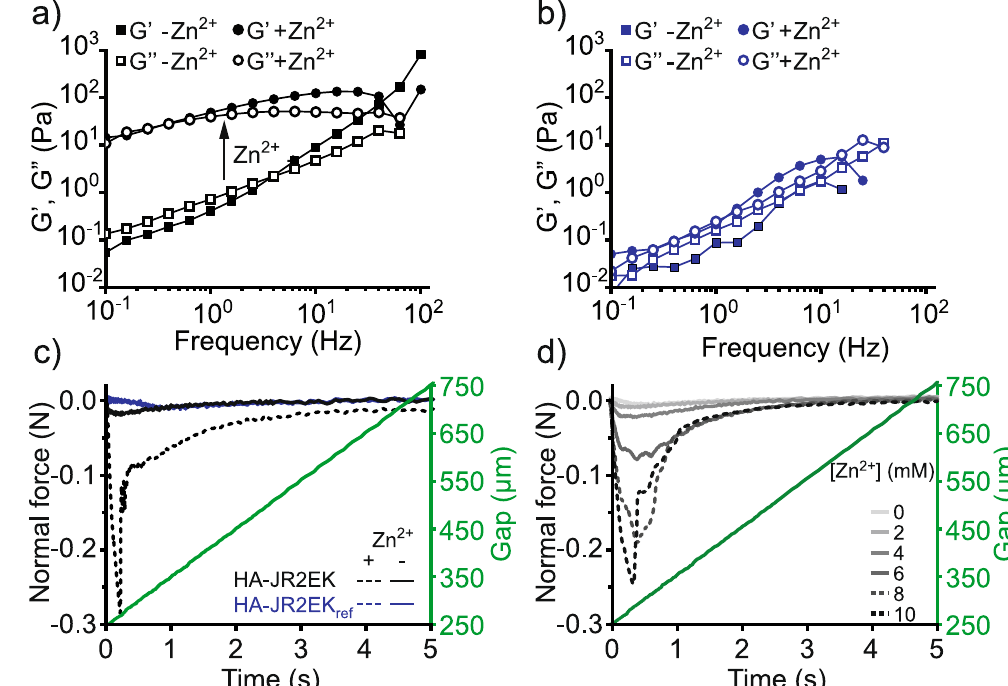
Figure 3. Rheological characterization of hydrogel formation induced by Zn 2 + . Rheological frequency sweeps of 2.5 wt % HA-JR2EK ( a ) and HA-JR2EK ref ( b ) with and without 10 mM Zn 2 + . ( c ) Probe tack tests of 2.5 wt % HA-JR2EK and HA-JR2EK ref with and without 10 mM Zn 2 + . ( d ) Probe tack test of 2.5 wt % HA-JR2EK with increasing [Zn 2 +